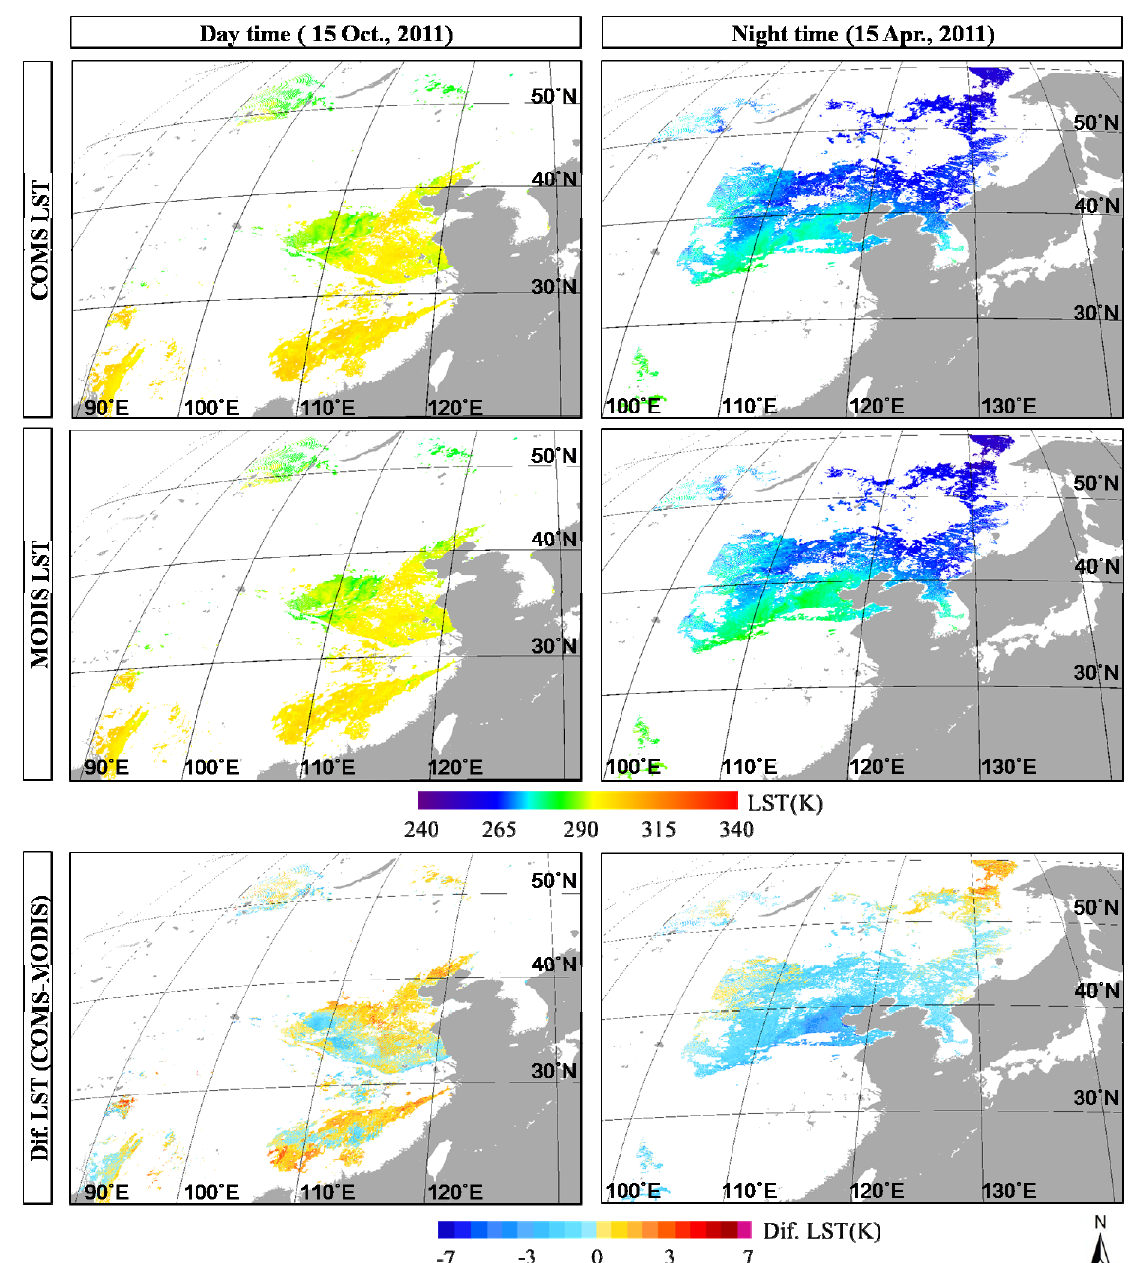
Figure 7. Spatial distribution of COMS LST and Moderate Resolution